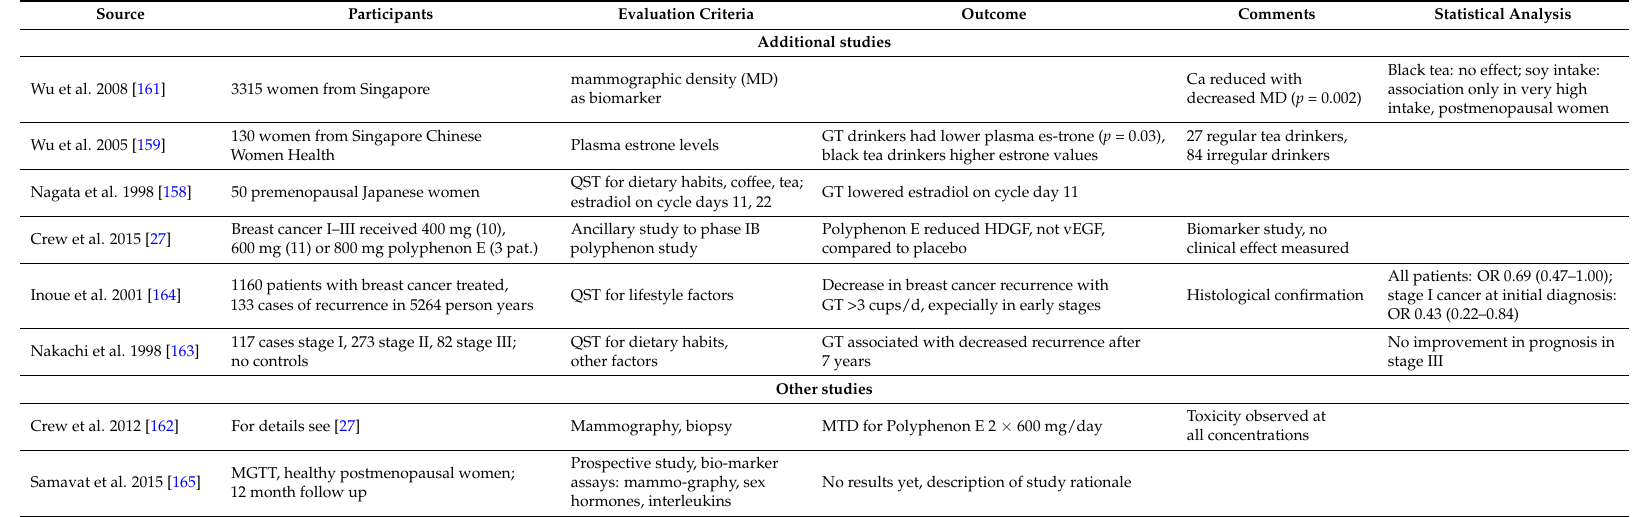
Table 5. Evidence for GT flavonoids, surrogate parameters and breast